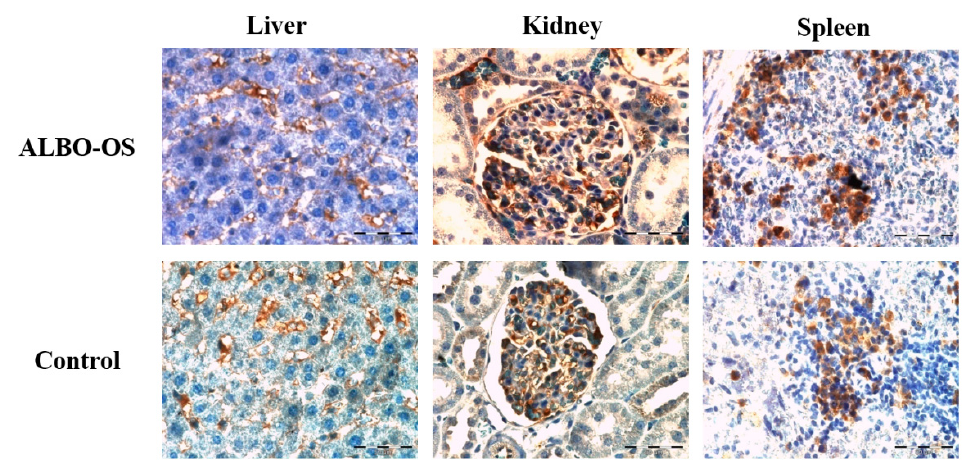
Figure 6. Representative images of Ki67 protein expression in rats’ liver, kidney and spleen tissue sections of experimental and control group, 40× magnification. Significant expression of Ki67+ cells was observed in all groups.